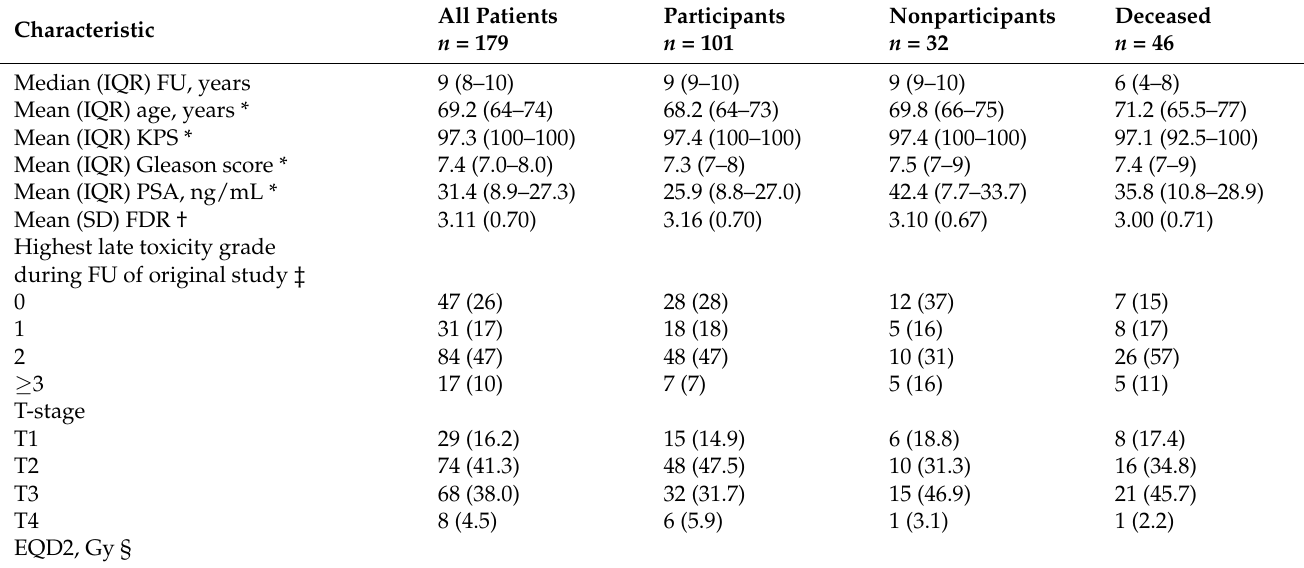
Table 3. Characteristics of participating, nonparticipating, and deceased